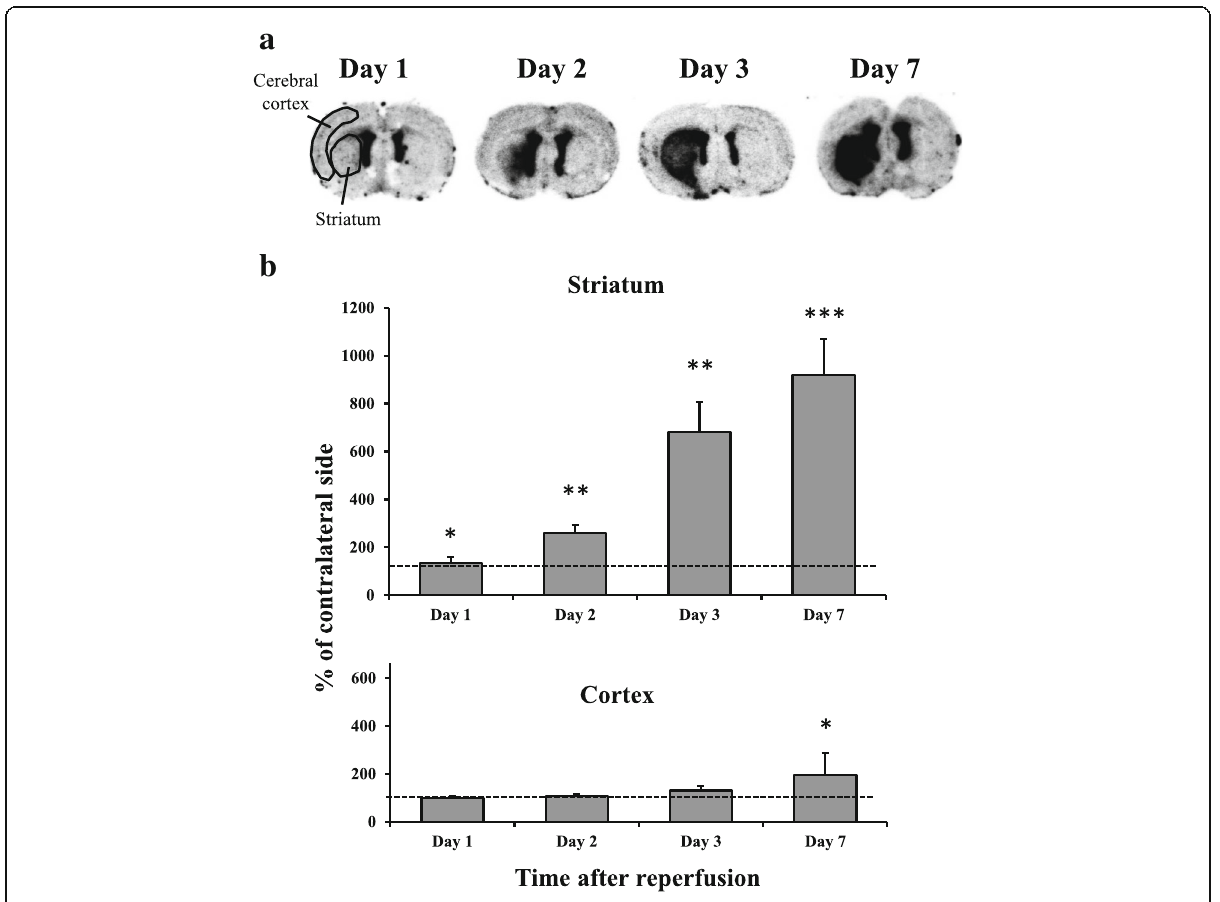
Fig. 1 Results of [ 18 F]DPA-714 binding in the brain after mild focal ischemia. a Typical autoradiograms of [ 18 F]DPA-714 binding in the brain after mild focal ischemia. Coronal sections at the level of the striatum were prepared at 1, 2, 3, and 7 days after 20-min middle cerebral artery occlusion (MCAO). The left side of each image is the ipsilateral side. b Temporal changes in [ 18 F]DPA-714 binding in the striatum and cortex after mild focal ischemia. Graphs show % of contralateral side, with values expressed as mean ± SD (day 1: n = 5, day 2: n = 5, day 3: n = 4, day 7: n = 6). Asterisks indicate significant differences compared with the contralateral side, * p < 0.05, ** p < 0.01, *** p <